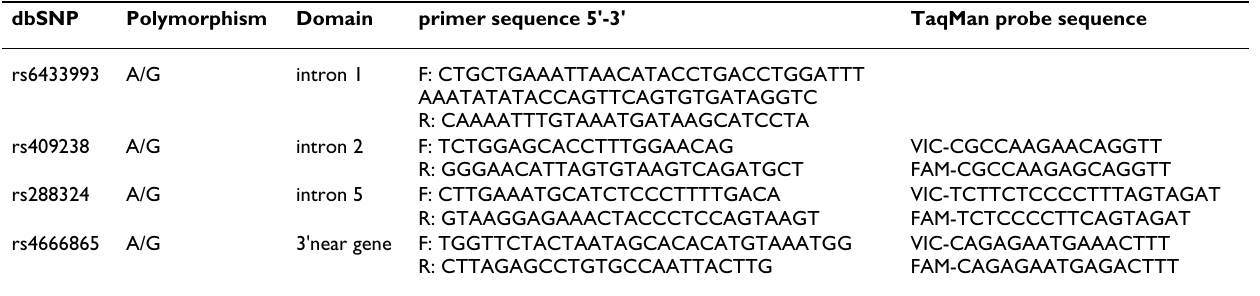
Table 1: Information and the primer and probe sequences for the studied SNPs in the FRZB gene